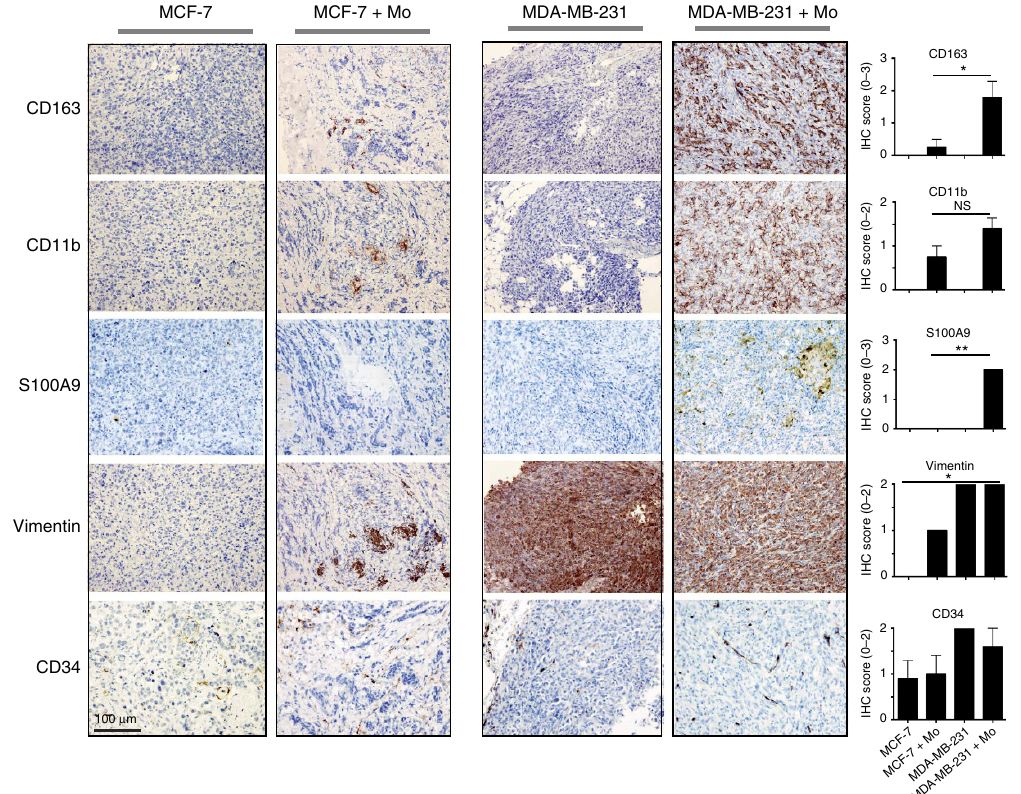
Figure 1 | IHC of xenografts. Tumour xenografts consisting of TN MDA-MB-231 breast cancer cells co-transplanted with primary human monocytes, express more myeloid-related and immunosuppressive markers than luminal A MCF-7/monocyte xenografts. The xenografts were grown in highly immunodeficient NSG-mice (see ‘Methods’ section), and sections from the tumours were stained with myeloid (CD163, CD11b, S100A9) tumour (vimentin) and endothelial markers (CD34). The two cell lines chosen are negative for S100A9 (ref. 21). IHC was performed using the indicated antibodies. All histological sections were counterstained with HE. N ¼ 5 mice were analysed for each group; MCF-7 grafts were analysed on day 21 and 90 post-graft with similar results—day 90 is shown here; TN MDA-MB-231 grafts were grown to day 21 only. The histograms show the mean value for each IHC score with statistical analyses. IHC scores are shown in Supplementary Table 1. * ¼ P o 0.05, ** ¼ P o 0.01 ANOVA non-parametric Kruskal–Wallis test. N ¼ 5. Error bars indicate